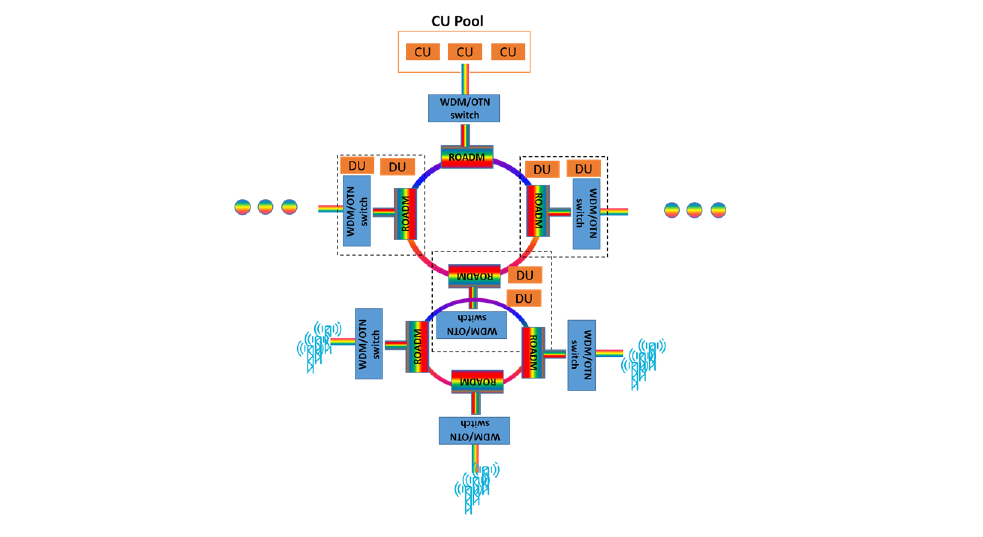
Figure 2. Next generation fronthaul